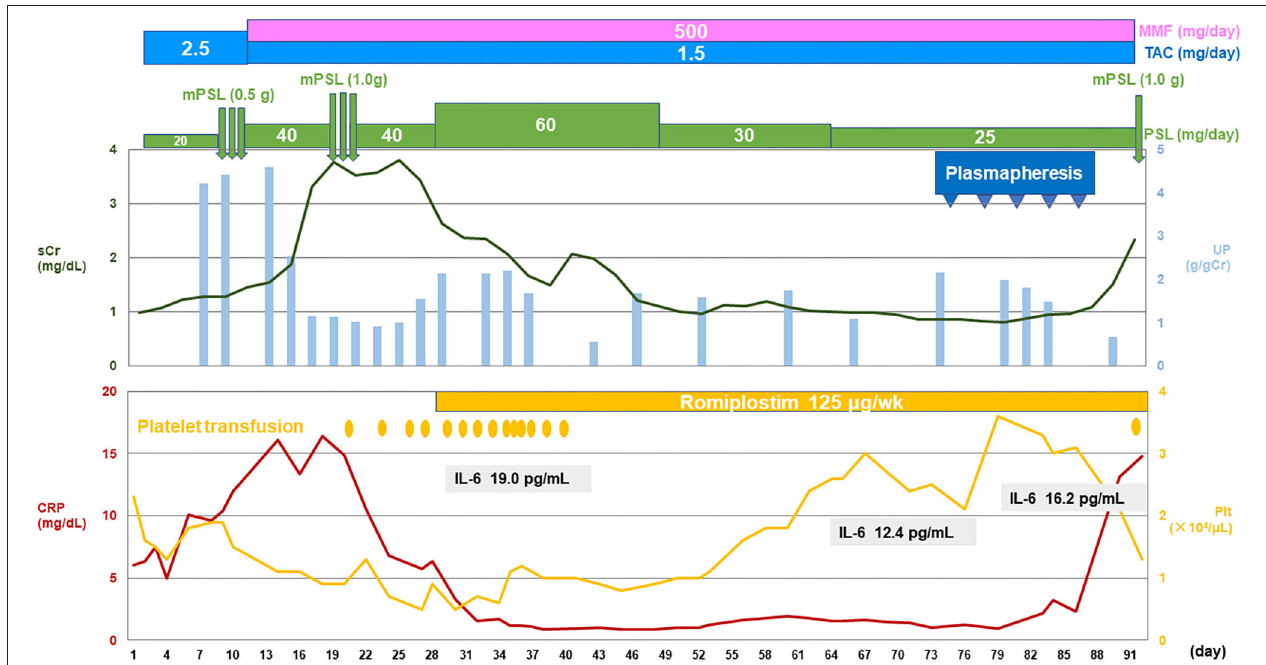
FIGURE 2 | The patient’s clinical course.CRP, C-reactive protein; IL, interleukin; MMF, mycophenolate mofetil; mPSL, methylprednisolone; Plt, platelet; sCr, serum creatinine; TAC, tacrolimus; UP, urinary protein.